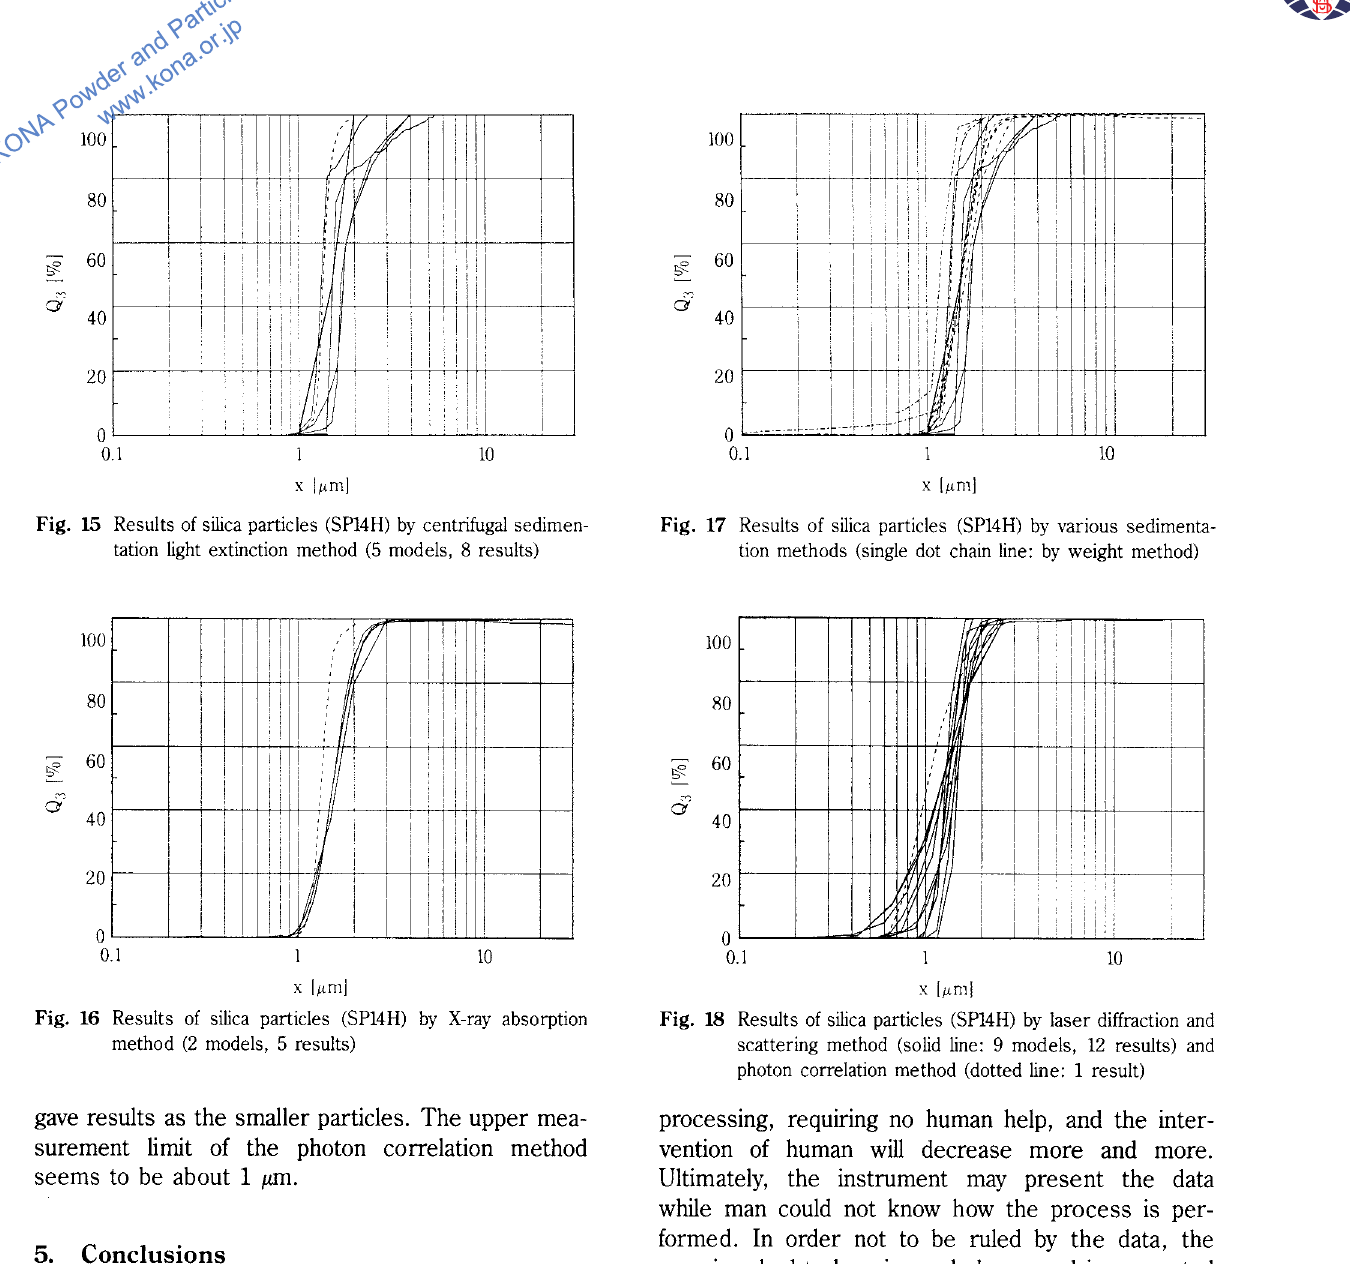
Fig. 15 Results of silica particles (SP14H) by centrifugal sedimen tation light extinction method (5 models, 8 results)